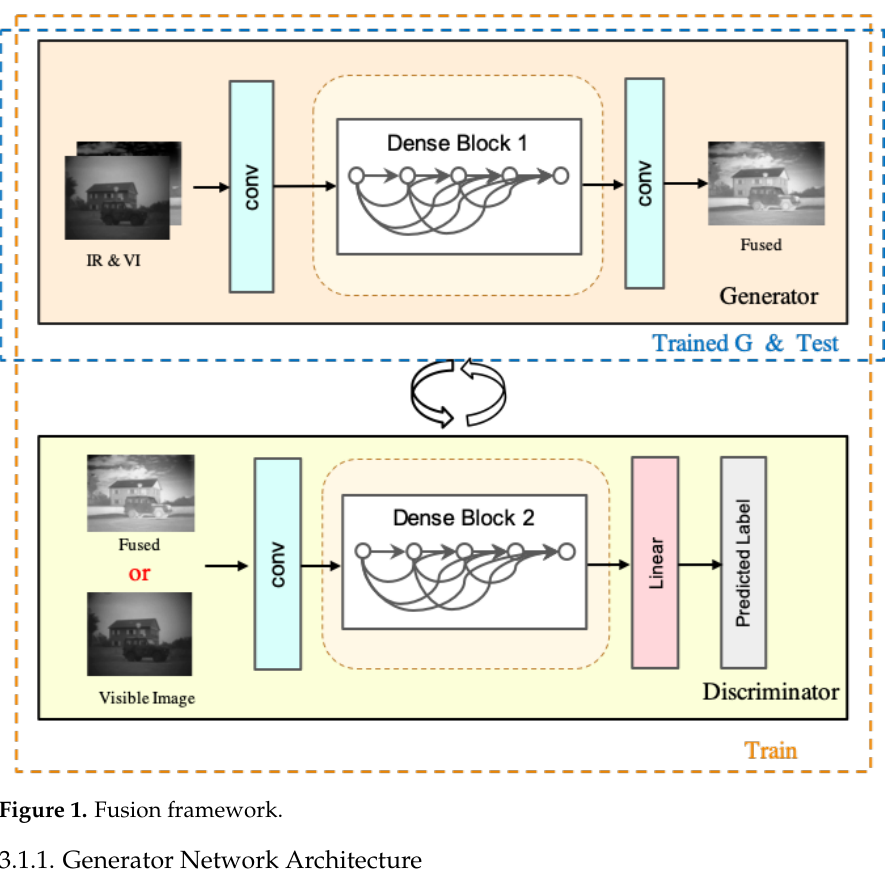
Figure 1. Fusion framework.